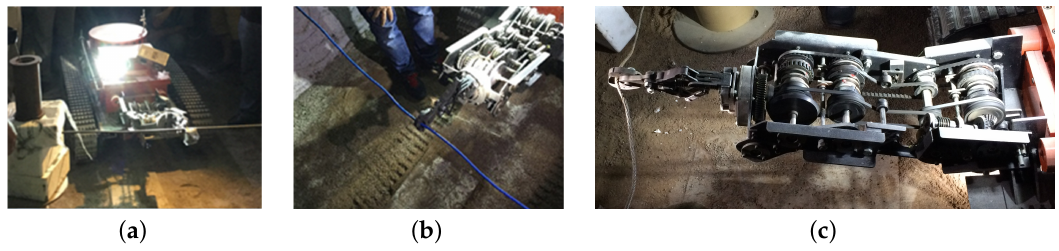
Figure 31. ( a – c ) show the manipulator cutting the steel roll bar, a thin cable and a steel tire operated remotely in the training center